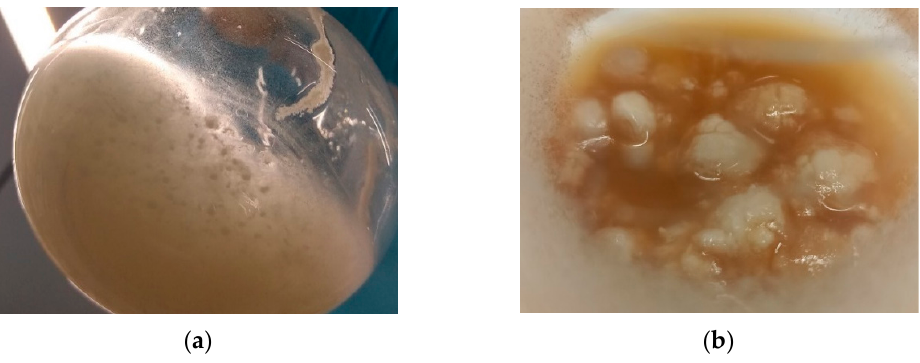
Figure 3. ( a ) Pellets obtained in synthetic media; ( b ) Morphology obtained in APH fermentations.